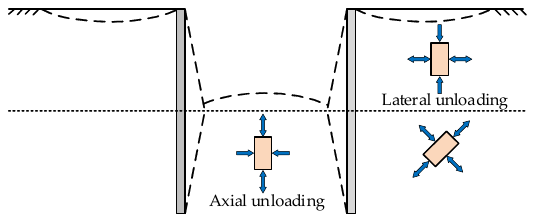
Figure 1. Unloading affected area of foundation pit excavation.